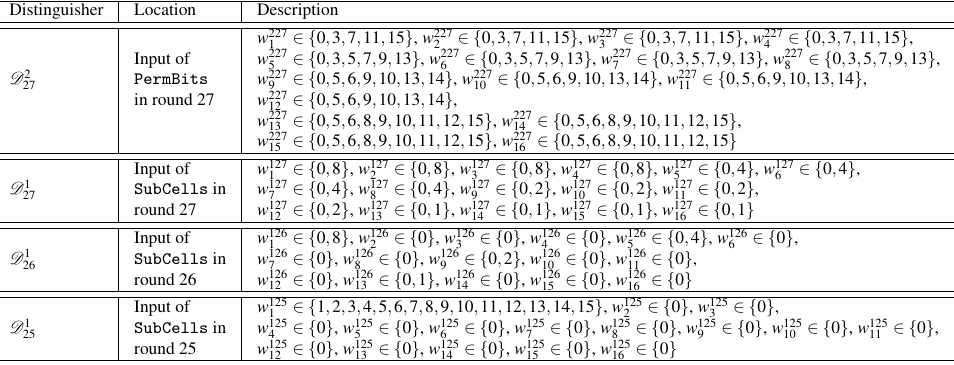
Table 4: Distinguishers of the best attack